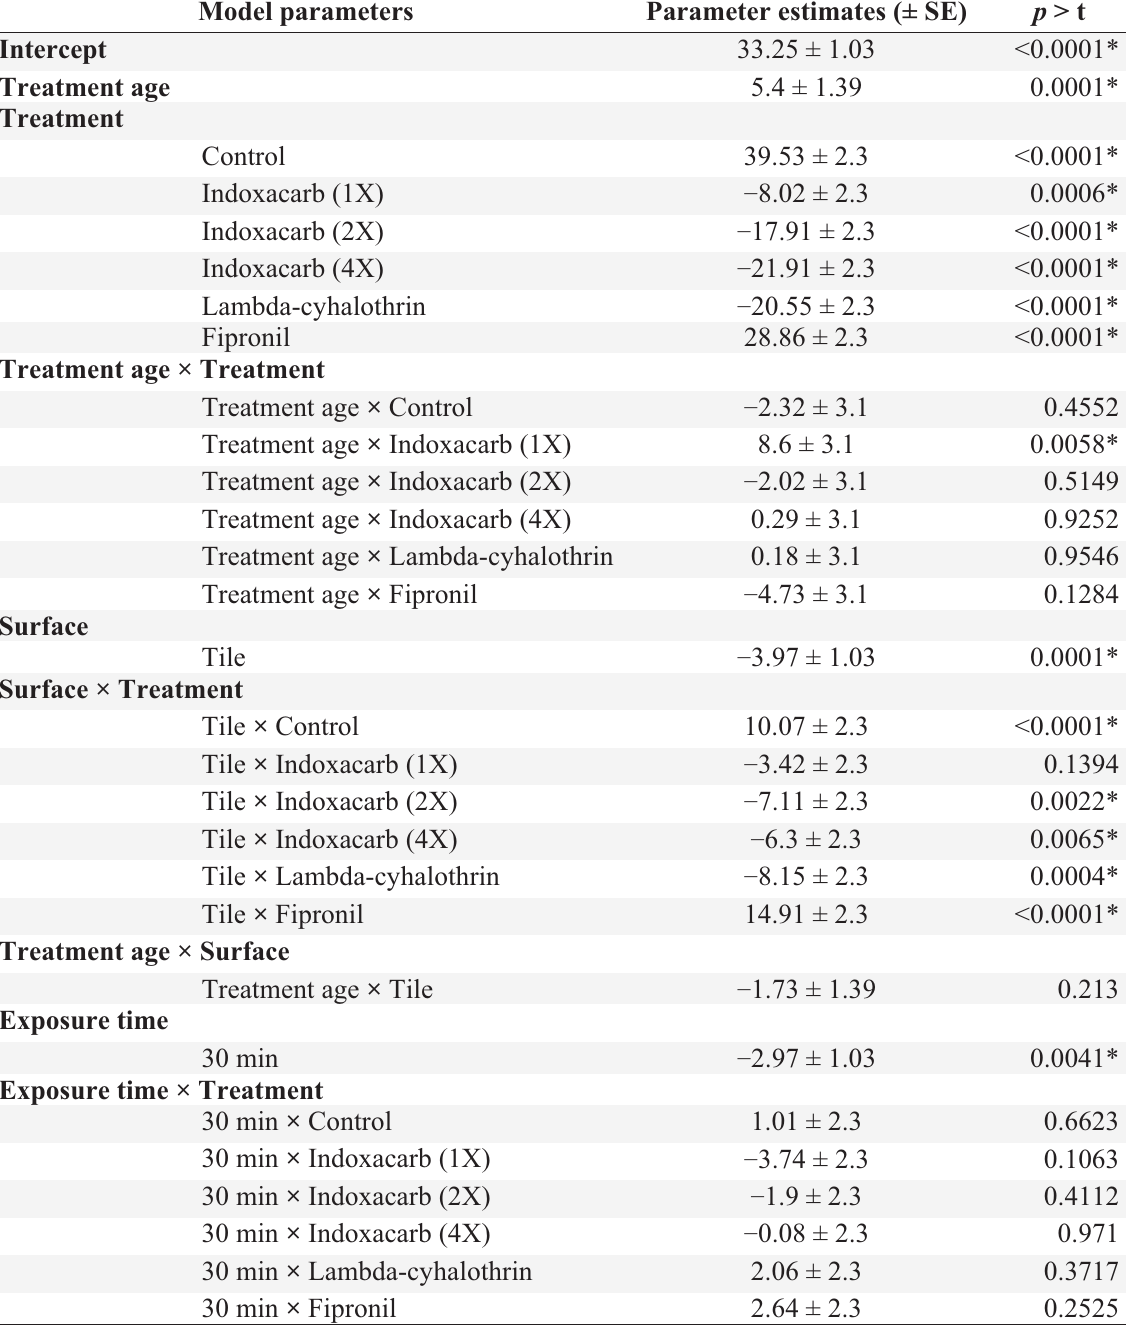
Table 2. Parameter estimates and significance values for a multiple regression analysis (R 2 = 0.55, F = 29.482, df = 24, 575, N = 600, p < 0.0001) on the percentage dark rover ant survival at 5 days after exposure to treated surfaces. The value of the parameter estimate for each level of the categorical variables and their interactions represents deviations from the mean dark rover ant survival of each of those variables. For categorical variables with two levels (surface and exposure time), one of the levels (wood and 5 min respectively) is not presented since its values are the same as that of the other level but with the sign of the parameter estimate inverted. This also applies to interactions of those